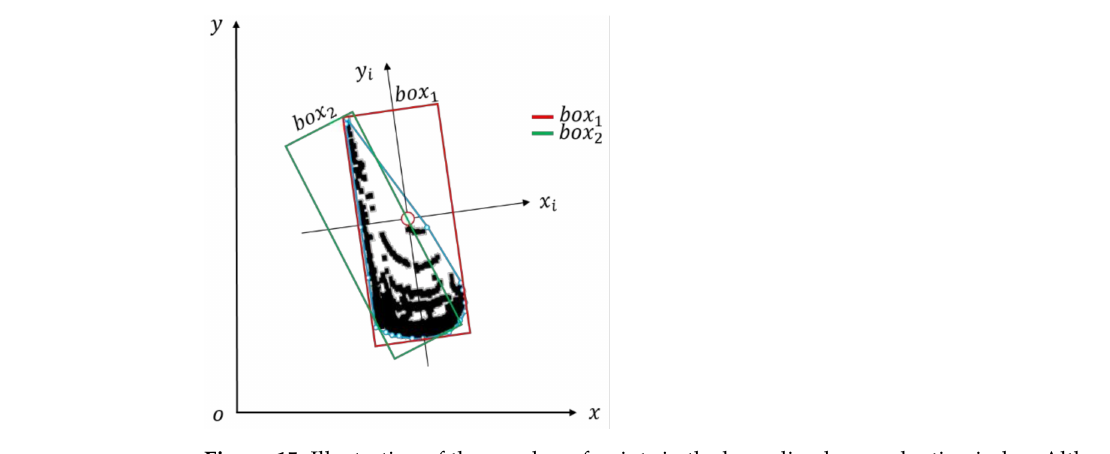
Figure 15. Illustration of the number of points in the bounding box evaluation index. Although box 2 box 2 has the smallest area, its bounding box fails to enclose all the point clouds. The box 2 has a larger area than box 1 , but it can enclose all point clouds, so box 2 ’s pose estimation effect was better than box 1 .